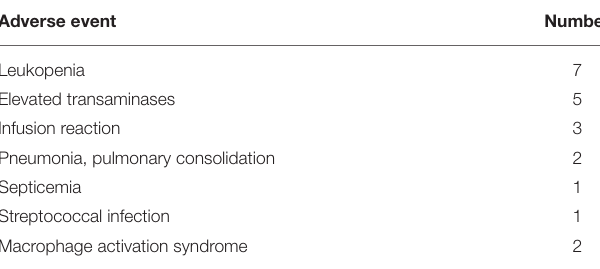
TABLE 3 | Adverse events in patients receiving tocilizumab. Adverse